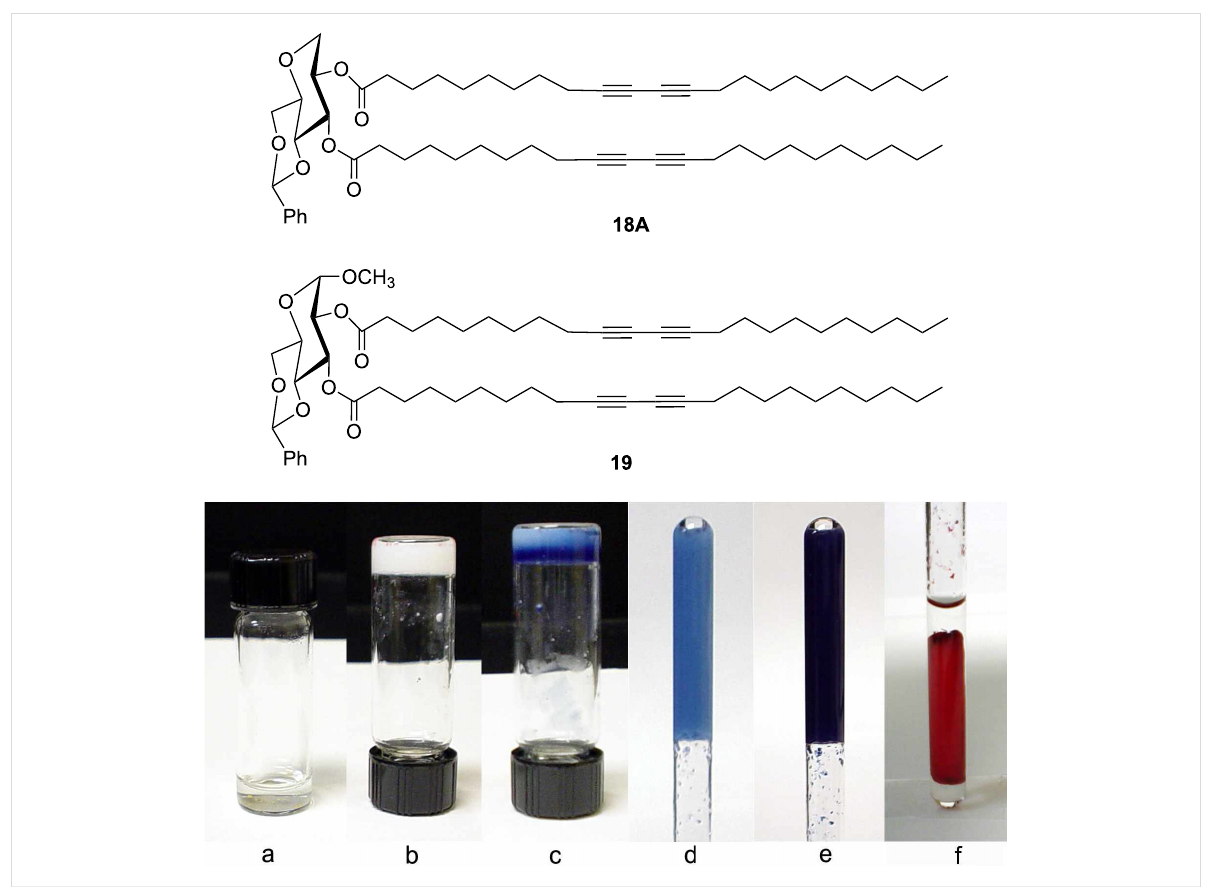
Figure 4: An ethanol gel formed by compound 18A at <10 mg/mL. a) A clear solution when heated above 70 °C; b) a stable gel after cooling to room temperature; c) a blue gel after illuminating with UV lamp from the top of the vial in b; d) a light blue gel inside quartz tube after UV treatment for 1 min; e) a dark blue gel in quartz tube after UV treatment for 3 min; f) the blue gel in e) turned red after